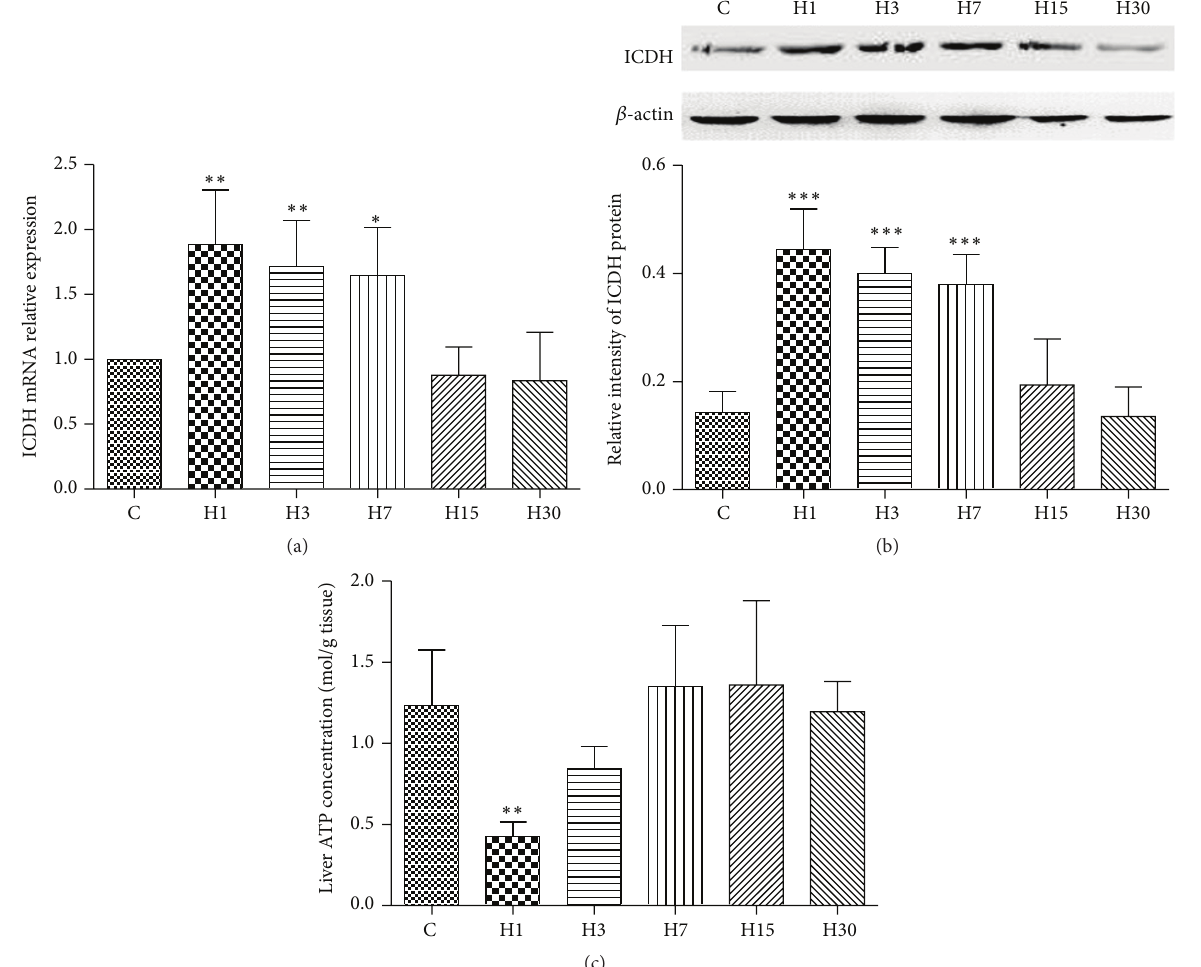
Figure 1: Relative expression of ICDH mRNA (a), ICDH protein (b), and liver ATP concentration (c) in rats exposed to HA. The expression of mRNA was measured by qPCR and the protein expression by western blot. The liver ATP concentration was measured by spectrophotometry. H1: rats were exposed to HA for 1 day; H3: rats were exposed to HA for 3 days; H7: rats were exposed to HA for 7 days; H15: rats were exposed to HA for 15 days; H30: rats were exposed to HA for 30 days. Control group: rats were not exposed to HA ( 𝑛 = 6 ). For ICDH mRNA